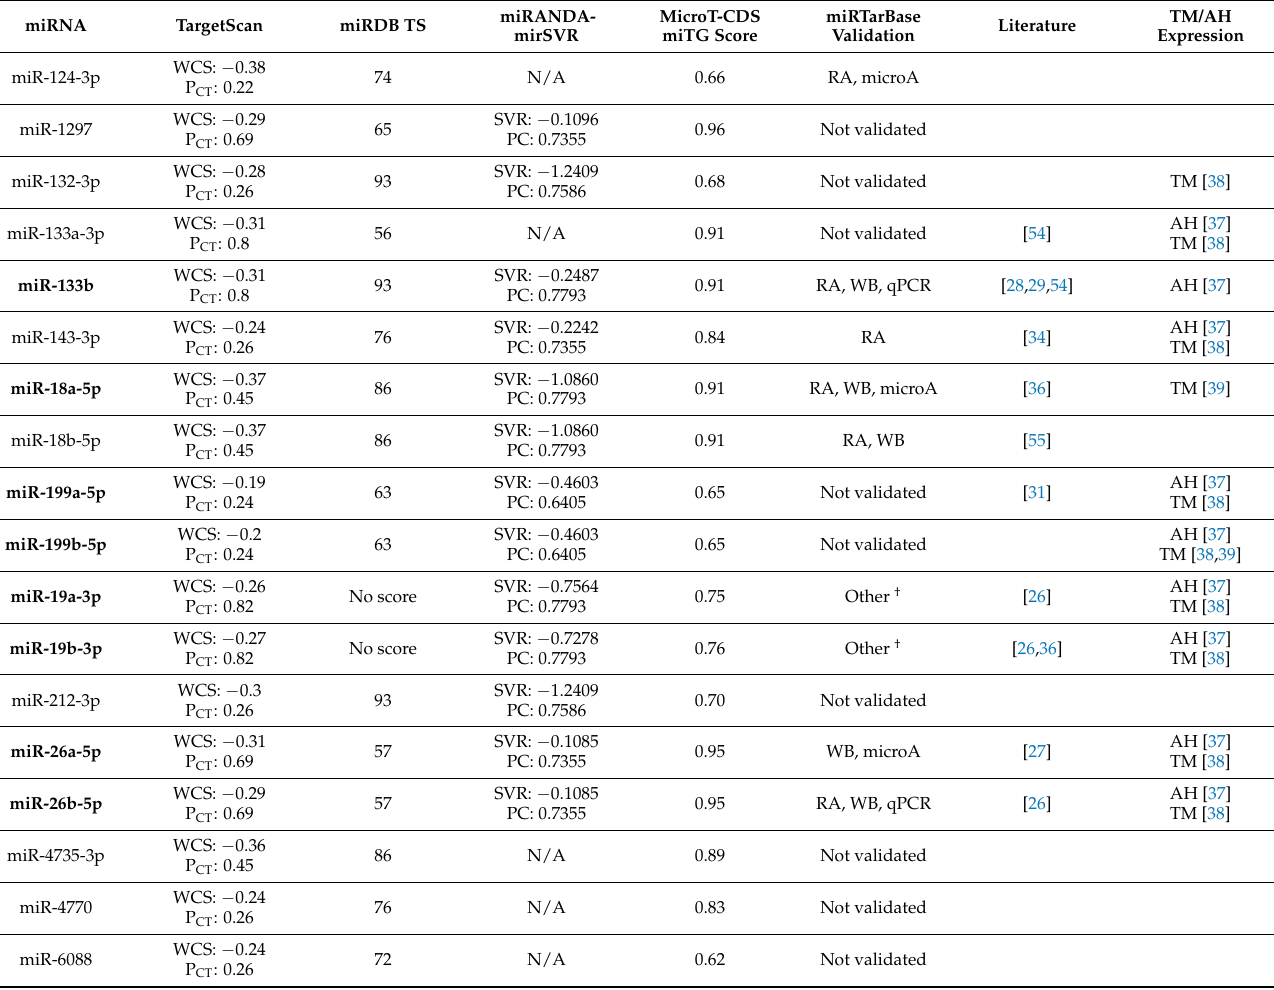
Table 2. Glaucoma-relevant miRNAs predicted or validated to target